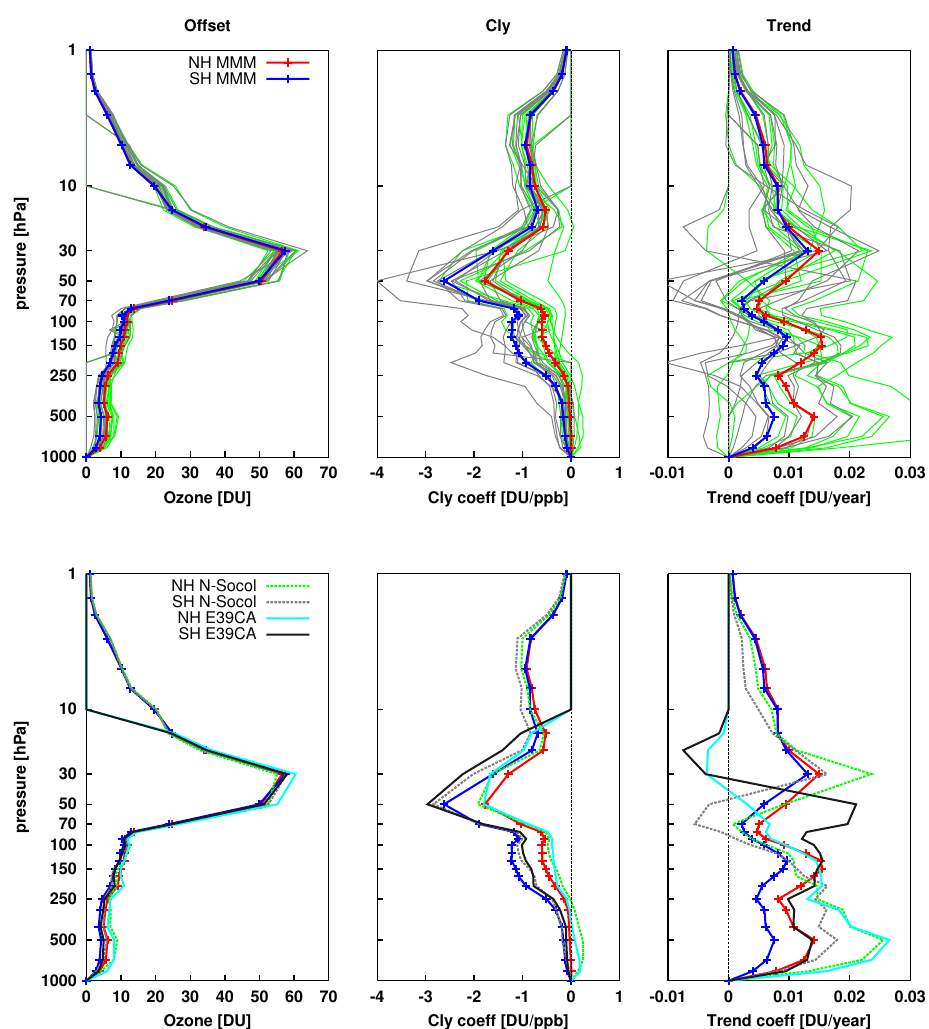
Fig. 4. Profiles of annual mean contribution to TOZ at each level in DU (1DU = 2 . 69 × 10 16 moleculescm − 2 ; the sum of the values over all pressure levels equals TOZ. The climatology (left), Cl y regression coefficient (middle) and trend coefficient (right) over the period 1960 to 2049 are shown for the multi-model mean of the NH (red) and the SH (blue) mid-latitudes. Individual models are shown in green for the NH and gray for the SH. The lower panels repeat the multi-model mean from above, and highlight the models NIWA-SOCOL and E39CA (see